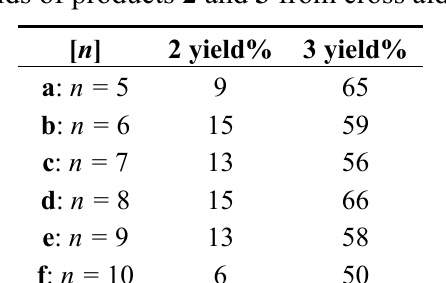
Table 1. The yields of products 2 and 3 from cross aldol condensation.